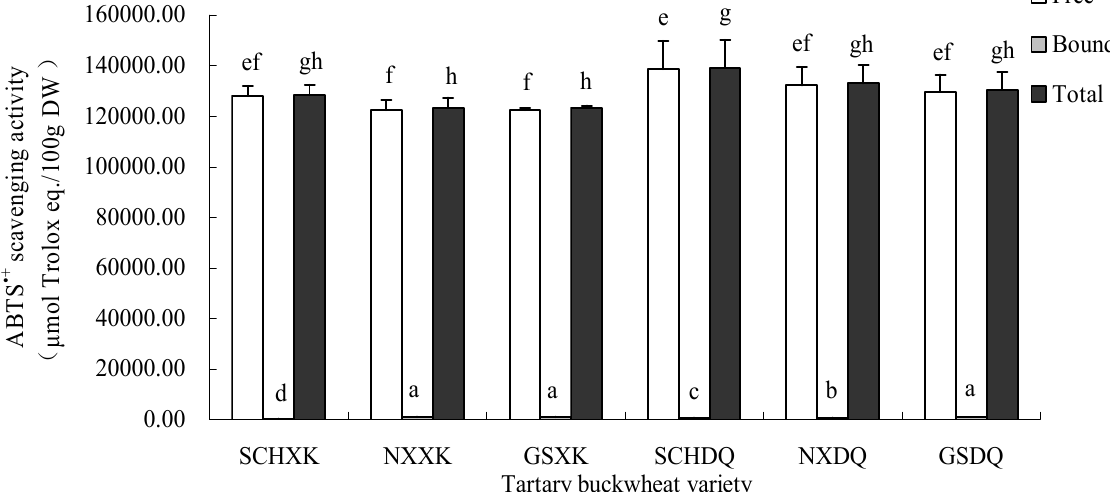
SCHXK, NXXK and GSXK represent Xingku No.2 grown in Sichuan, Ningxia and Gansu respectively, SCHDQ, NXDQ and GSDQ represent Diqing grown in Sichuan, Ningxia and Gansu, respectively. The error bars represent the standard deviation ( n = 3). Values marked by the same letter are not significantly different ( P <